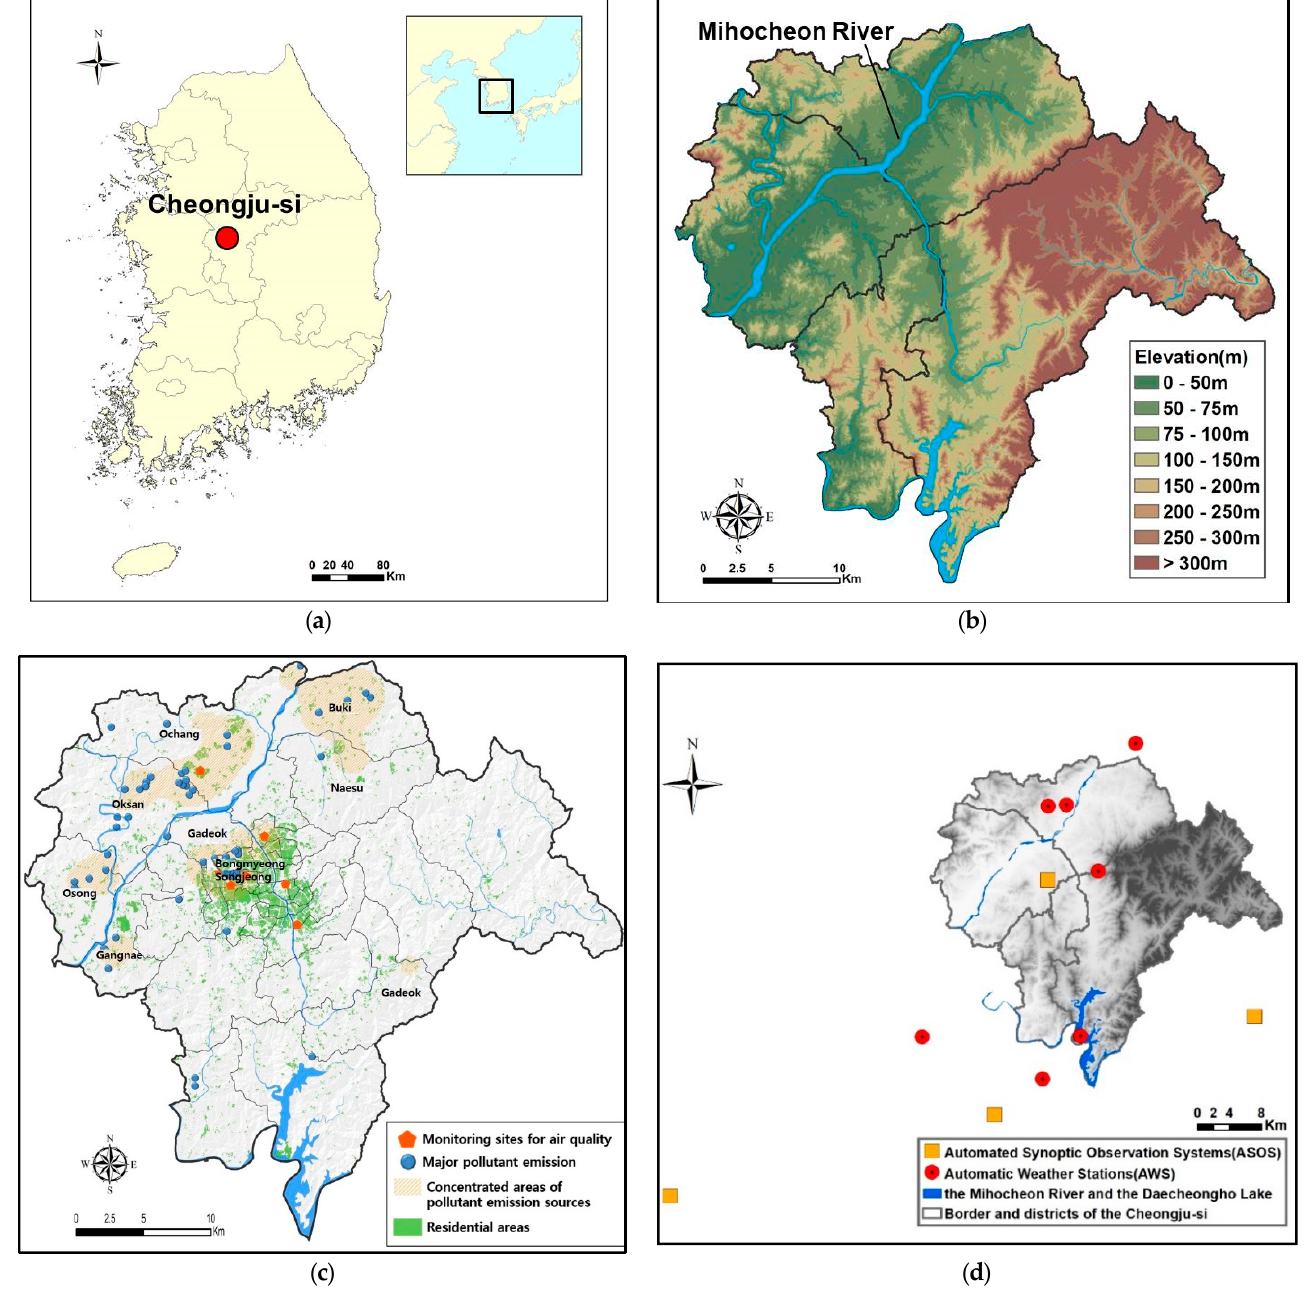
Figure 2. Overview of the study area, Cheongju-si, Korea: ( a ) location, ( b ) elevation, ( c ) major air pollutant emission sources, ( d ) meteorological observation sites, and (Source of ( c ): [23], translated with the consent of publishers).